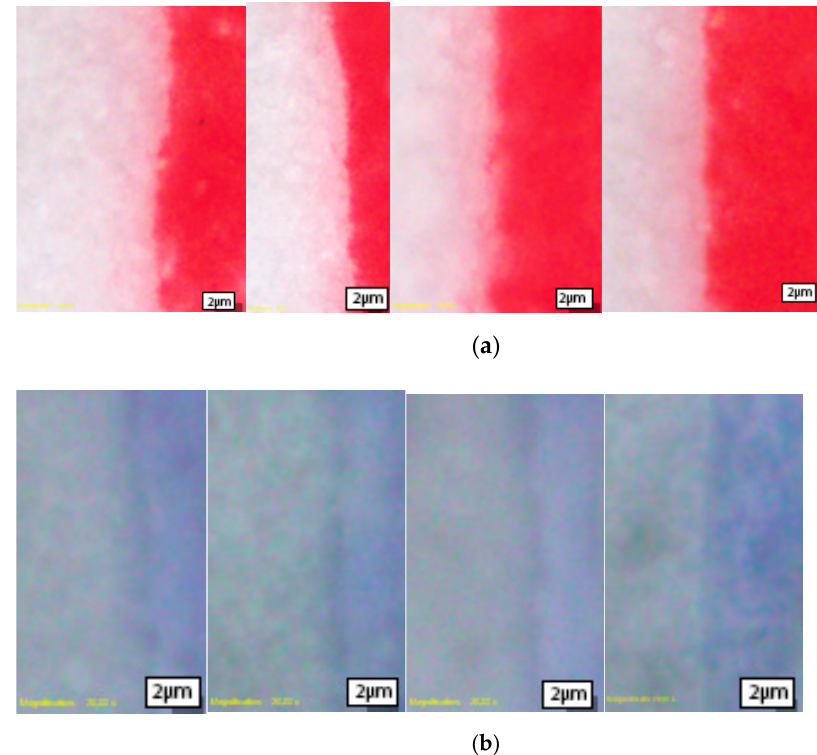
Figure 2. Vertical edge profiles: ( a ) conventional ink; ( b ) thermochromic ink.